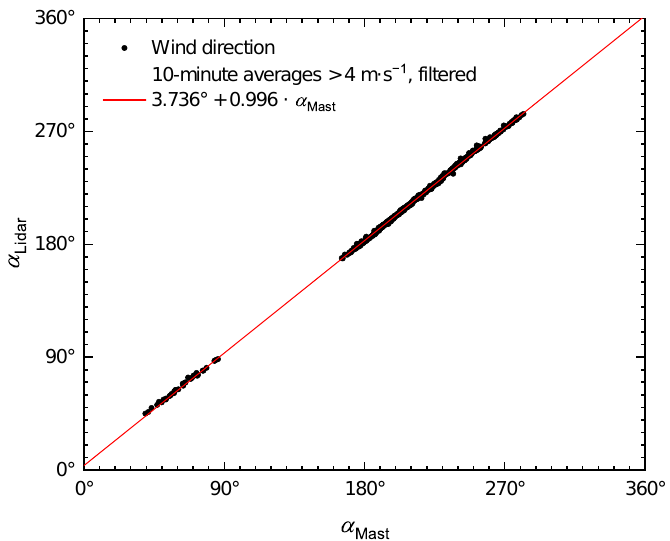
Figure 17. Results of the 2020 comparative measurement between the PTB bistatic lidar and a cup anemometer mounted on top of a 200 m met mast, showing the linear orthogonal regression of the filtered wind directions measured by the PTB bistatic lidar and the wind vane mounted on the met